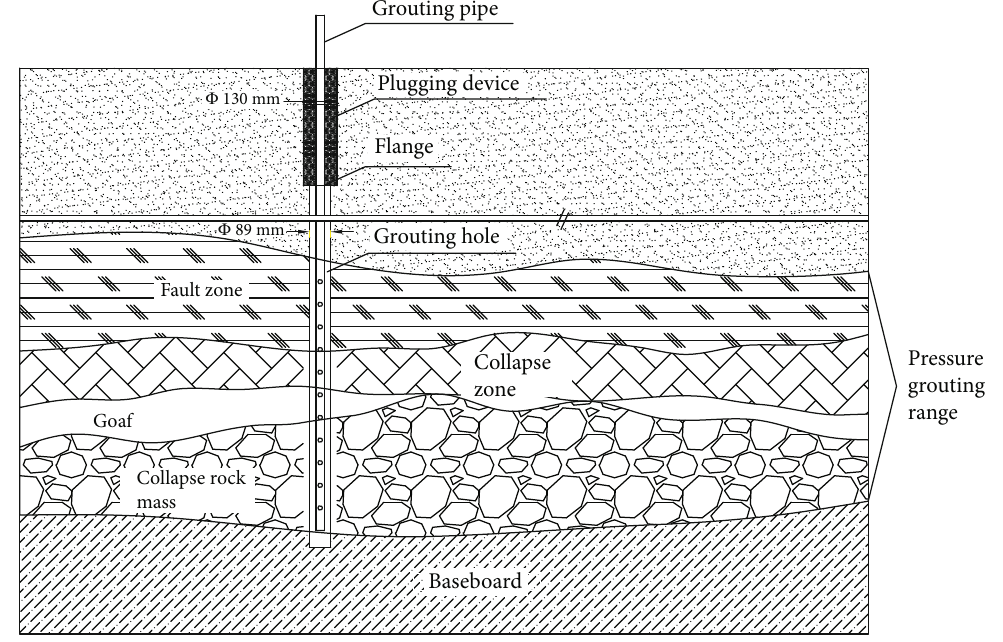
Figure 1: Schematic diagram of foundation grouting treatment in